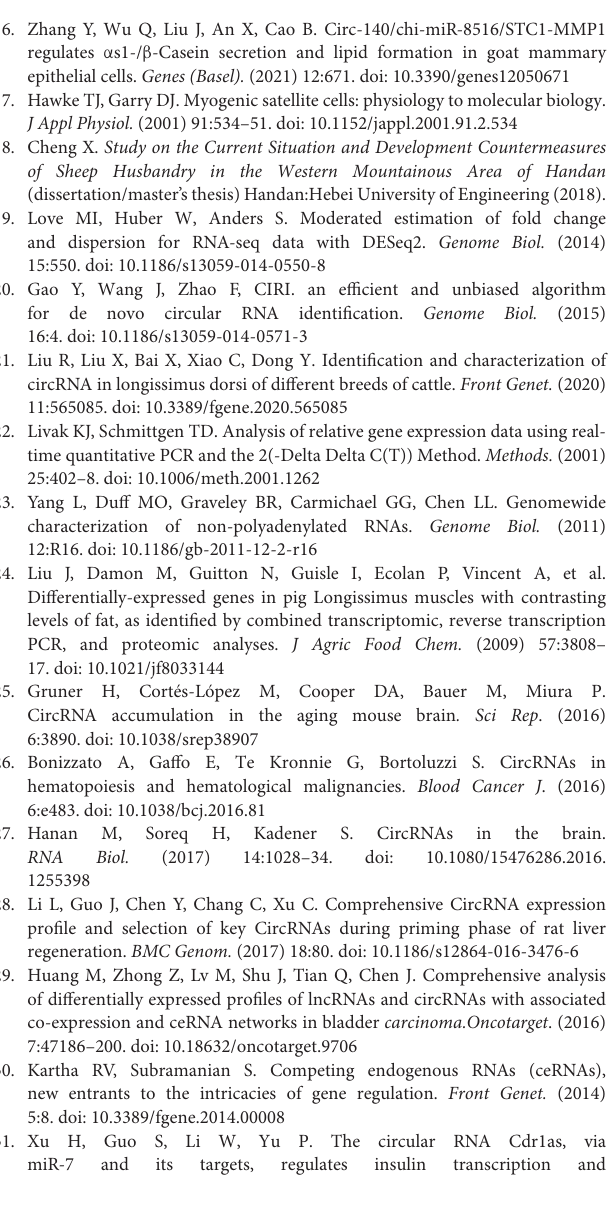
Supplementary Table 1 | All circRNAs and their host genes identified in this study. Supplementary Table 2 | Length data of all identified circRNAs. Supplementary Table 3 | Results of differentially expressed circRNAs. Supplementary Table 4 | Correlation analysis results of miRNAs and circRNAs that have a targeting relationship with miRNAs and mRNAs that have a targeting relationship with